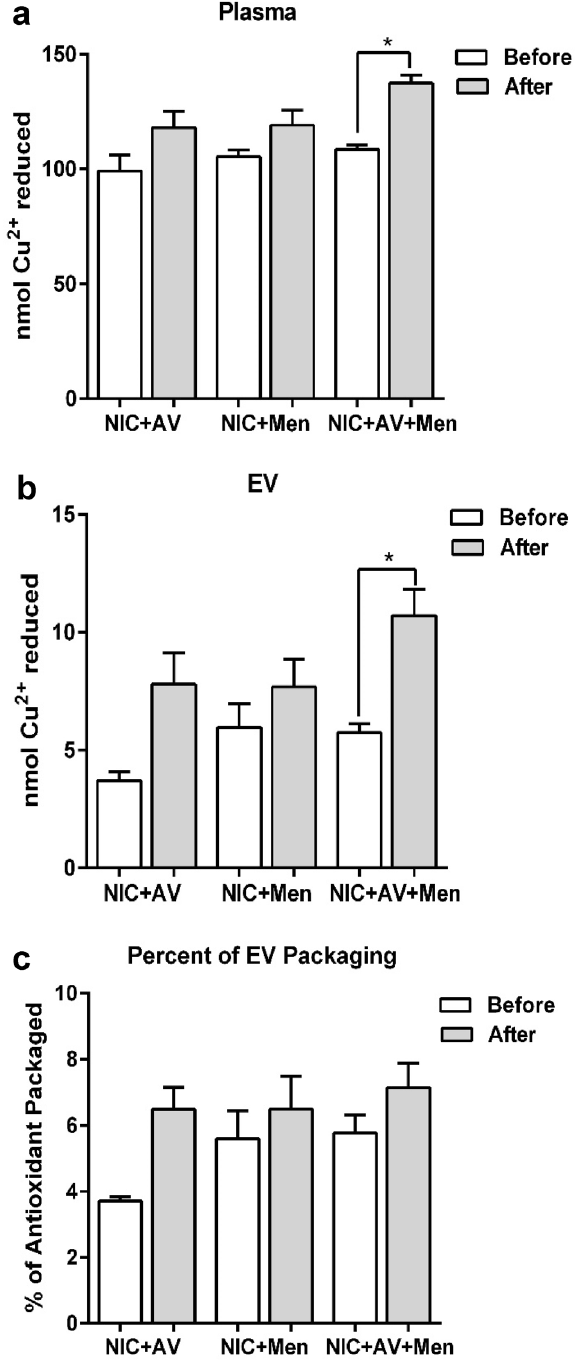
Figure 5. Trolox equivalent of total antioxidant capacity (TAC) in rat plasma and EVs. ( a ) Plasma obtained ‘before’ and ‘after’ self-administered nicotine in the presence of either AV, menthol or combined (NIC: Nicotine, AV: Audiovisual, Men: Menthol). ( b ) EVs were isolated from rat plasma obtained ‘before’ and ‘after’ self- administered nicotine in the presence of either AV, menthol or combined. ( c ) Percent of EV packaging. Results are expressed as means ± S.E.M of n = 3–4 experiments. *p < 0.05, in comparison with before nicotine self-